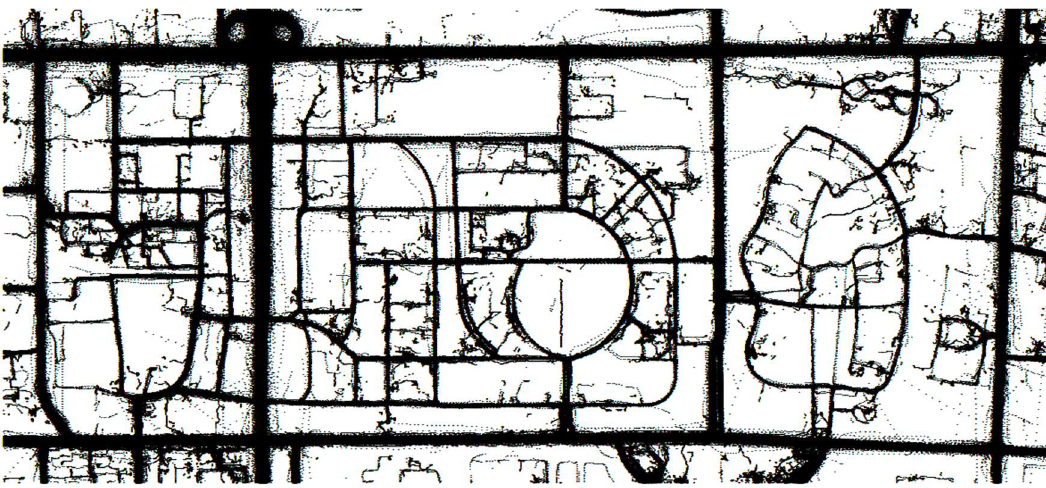
Figure 9. Raw research data. The black dots represent GNSS (Global Navigation Satellite System) points.